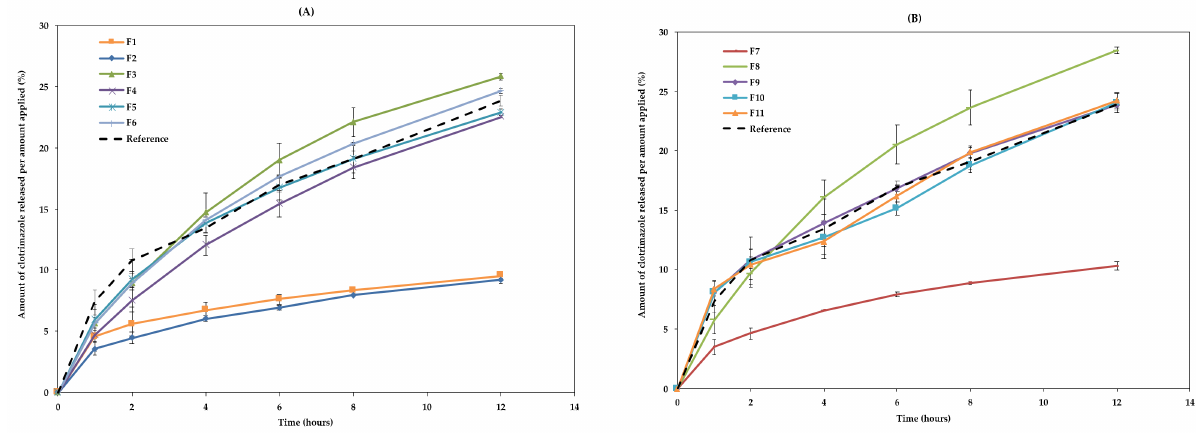
Figure 4. Cumulative release drug through membranes: ( A ) F1–F6 and RF; ( B ) F7–F11 and RF. The results are mean ± SD, n =